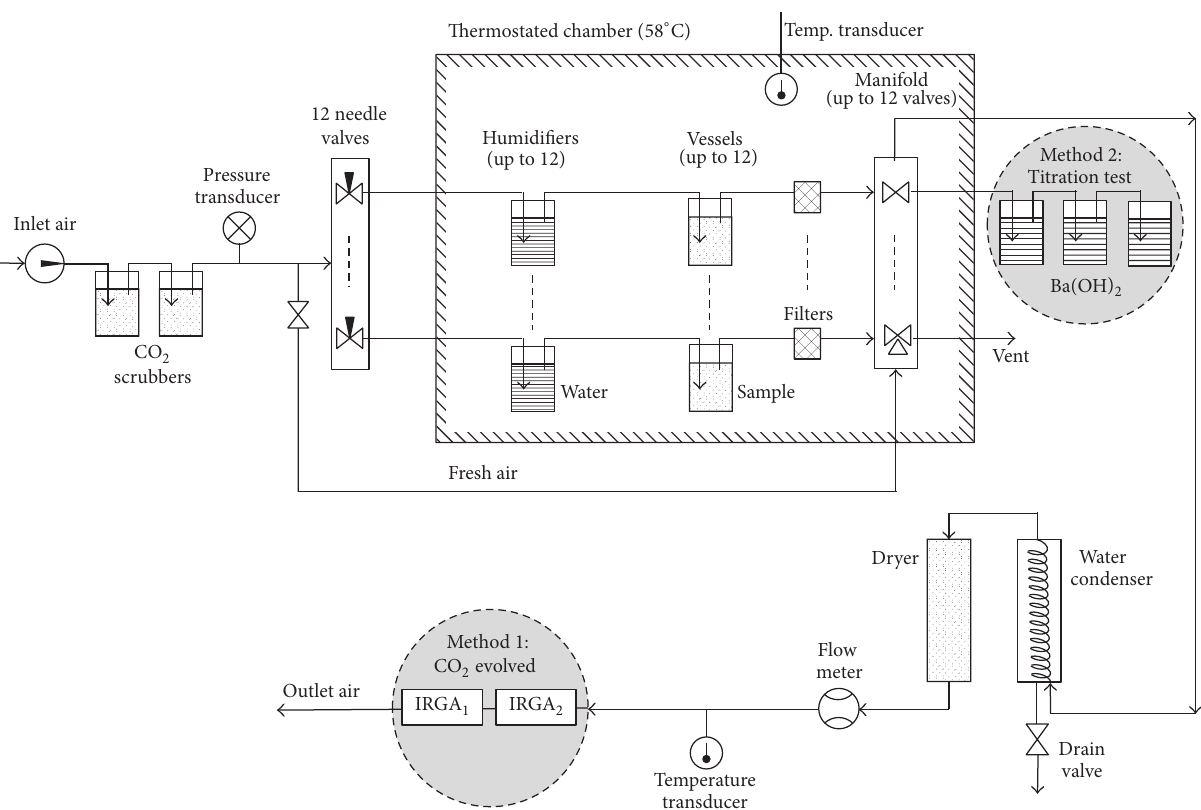
Figure 1: Schematic diagram of the experimental apparatus. CO 2 evolved (method 1) and titration test (method 2) are used to evaluate the biodegradation of